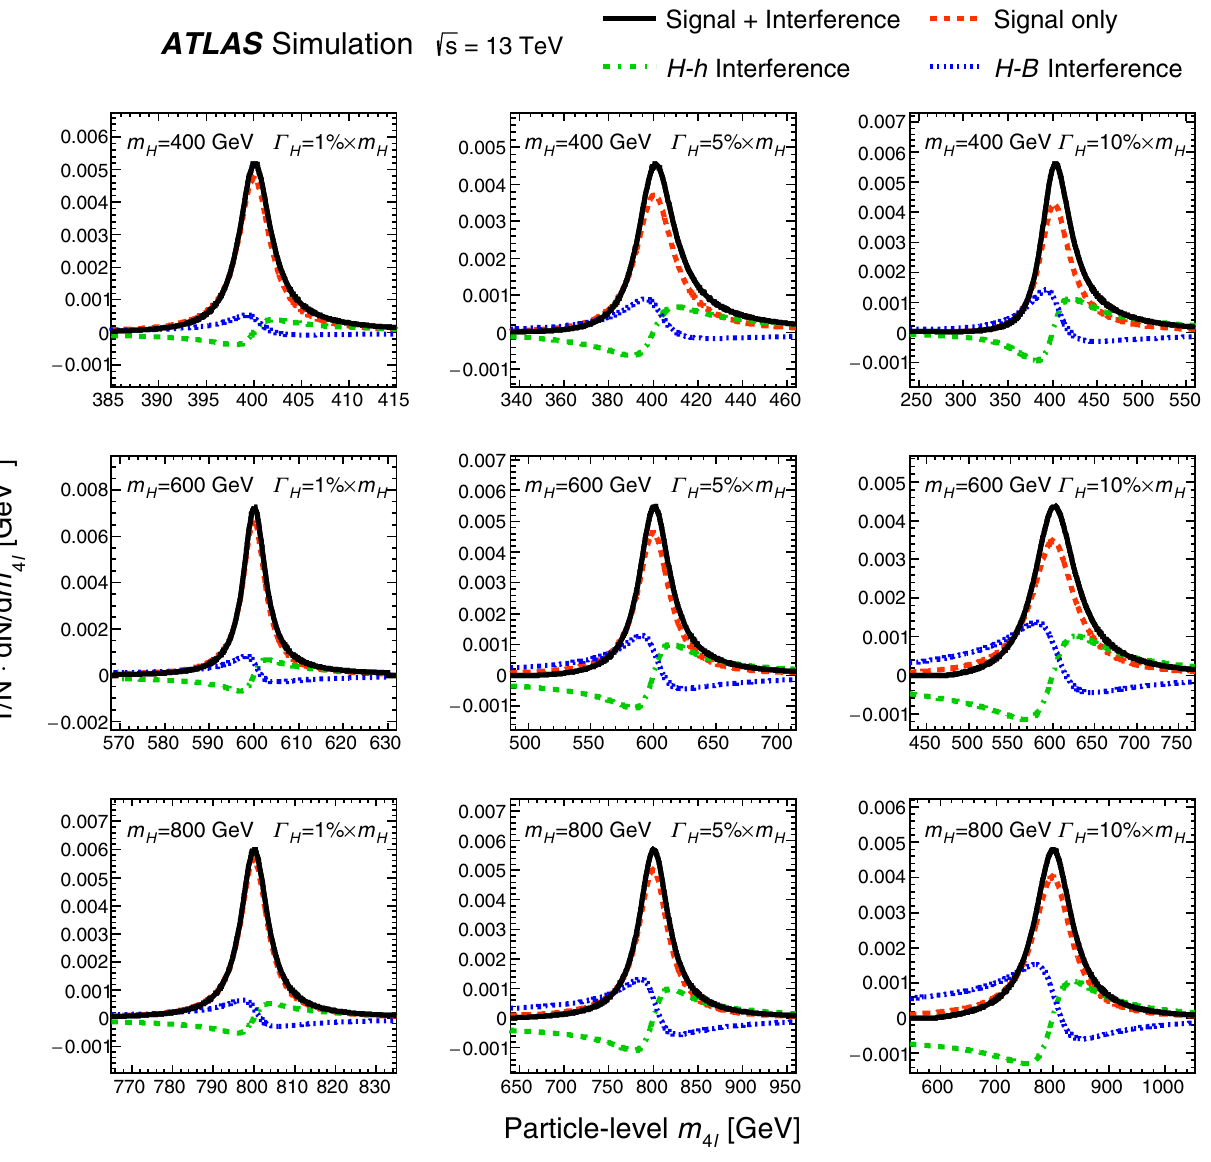
Fig. 2 Particle-level four-lepton mass m 4 (cid:3) model for signal only (red), H – h interference (green), H – B interference (blue) and the sum of the three processes (black). Three values of the resonance mass m H (400, 600,800GeV)arechosen,aswellasthreevaluesoftheresonancewidth (cid:15) H (1, 5, 10% of m H ). The signal cross section, which determines the